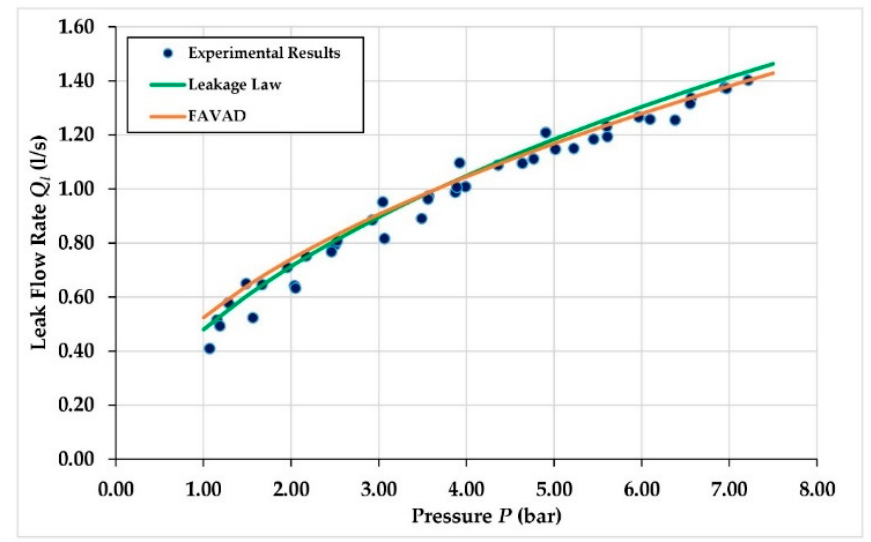
Figure 7. Comparison between experimental results and leakage law and FAVAD models.